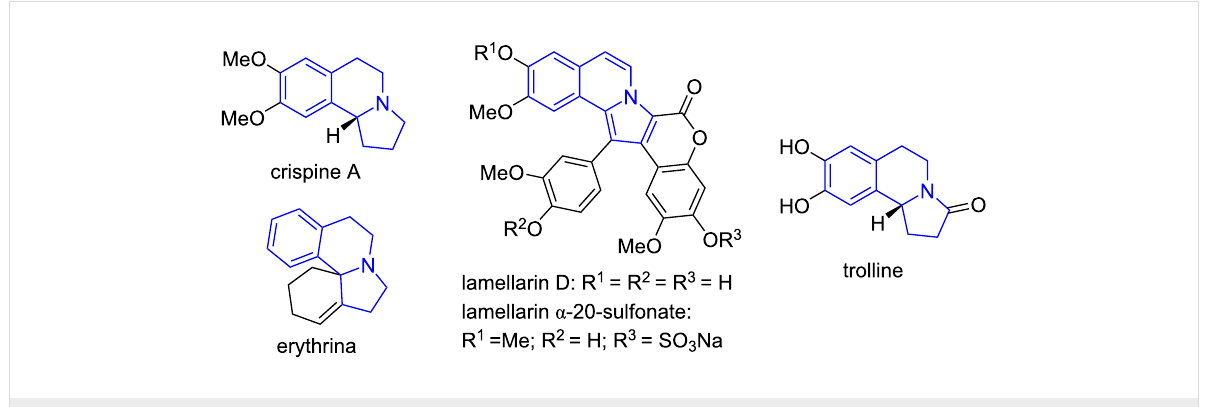
Figure 1: Bioactive pyrrolo[2,1- a ]isoquinolines and hexahydropyrrolo[2,1- a ]isoquinolines.